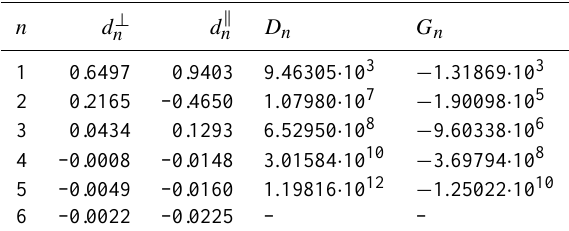
Table 1. The coefficients of expansion of the potential U cf in spher- k ical harmonics (d ⊥ n , d n ) and in Bessel functions (D n , G n )